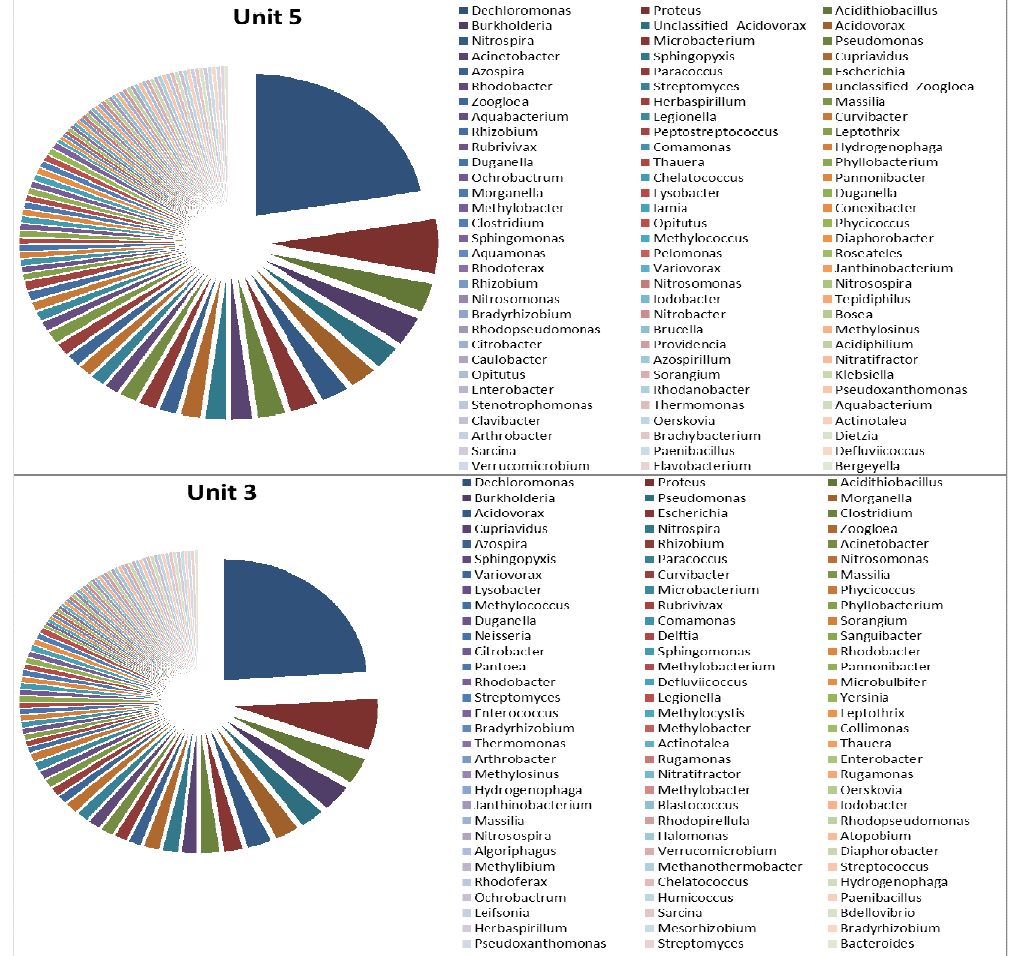
Figure 10. Microbial diversity (by genus) of aerobic zones in Unit-5 and Unit-3 of the Northern Wastewater Treatment Works, Johannesburg, South